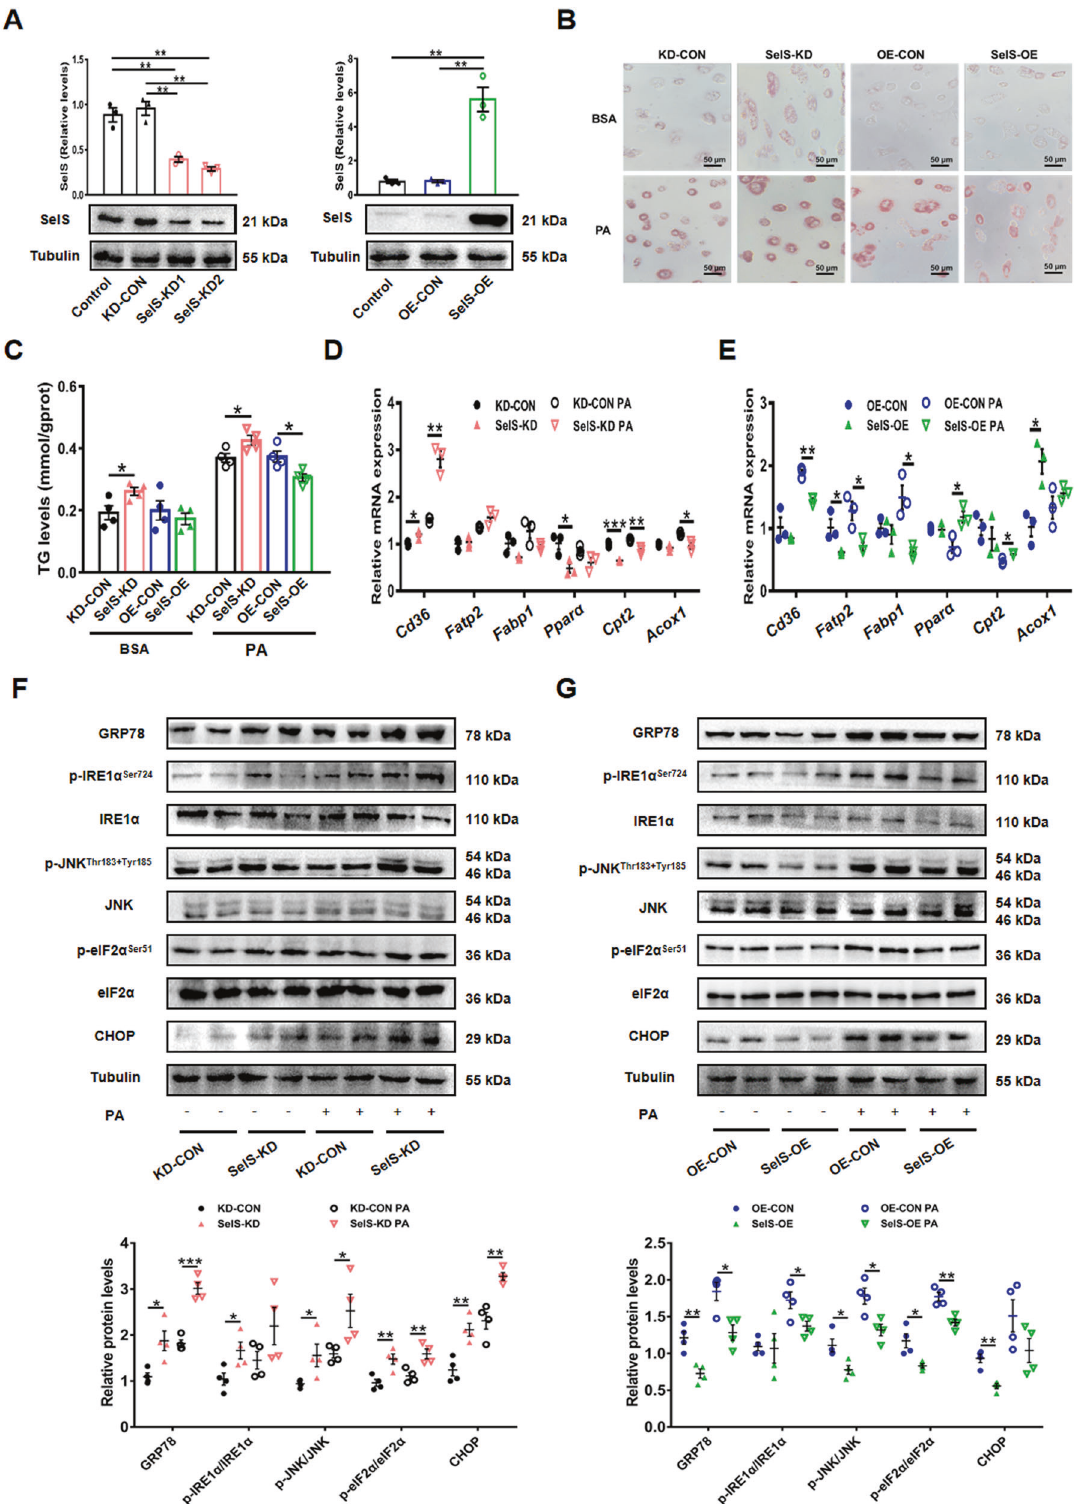
that hepatic SelS performs vital regulatory functions in meta- bolic processes. These fi ndings were in accordance with further studies in SelS H-KO mice. We reveal that the loss of hepatic SelS leads to obesity, hepatic steatosis, IR and disturbed glucose